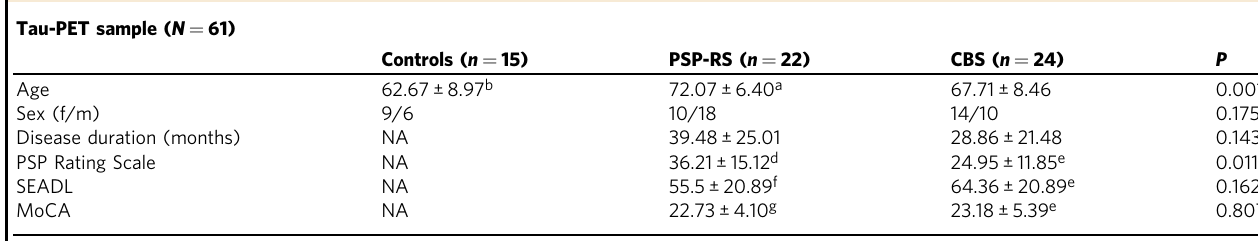
MoCA Montreal Cognitive Assessment Battery, SEADL Schwab and England Activities of Daily Living. a Signi fi cantly different from controls ( p <0.05). b Signi fi cantly different from PSP-RS ( p <0.05). c Available for 19/22 PSP-RS subjects.